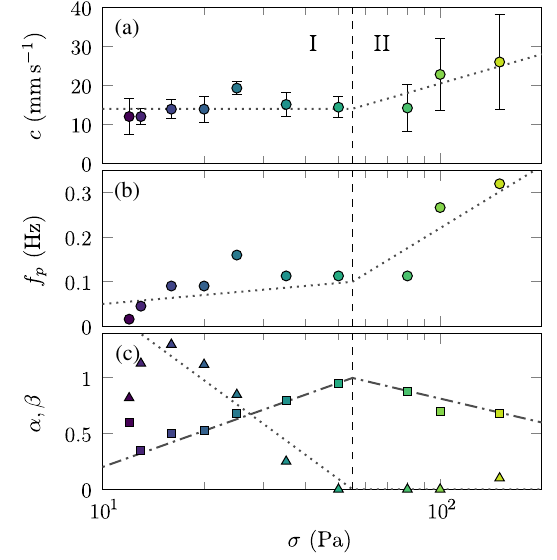
FIG. 5. Characterization of the dynamics as a function of the applied stress σ . (a) Speed c of propagating events. Error bars correspond to the standard deviation taken over all detected events. (b) Occurrence frequency f of propagating events. p (c) Coefficients α (triangles) and β (squares) of the best fit